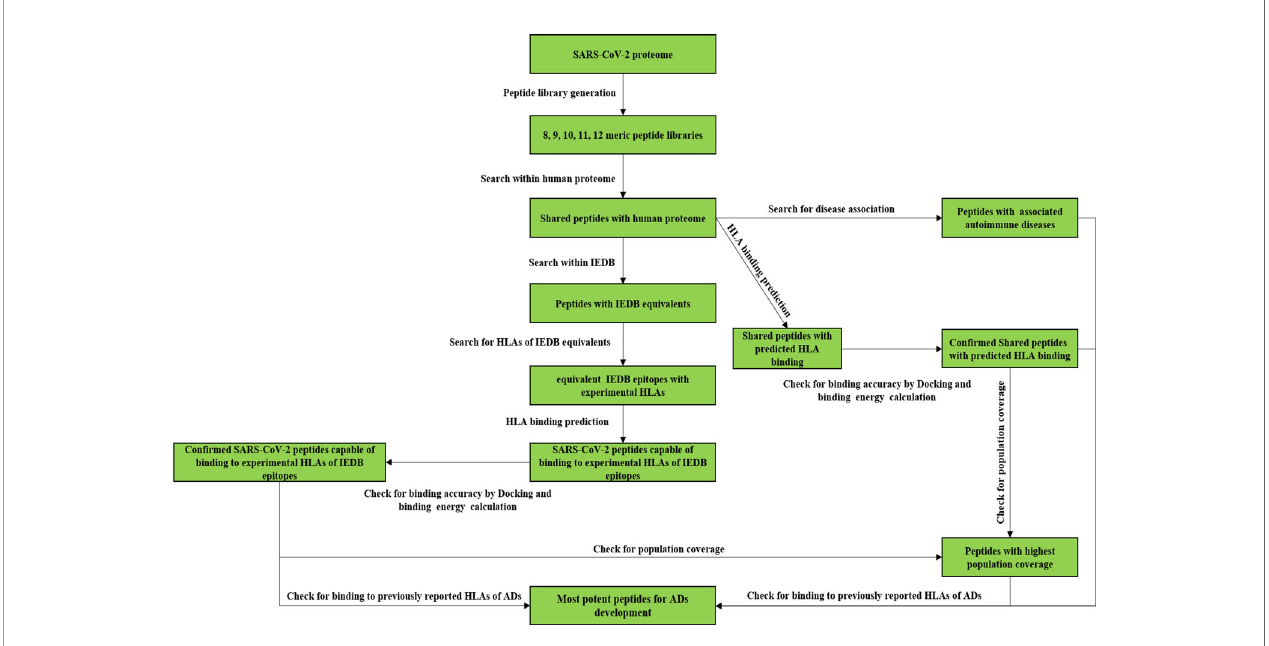
FIGURE 1 | The study follow